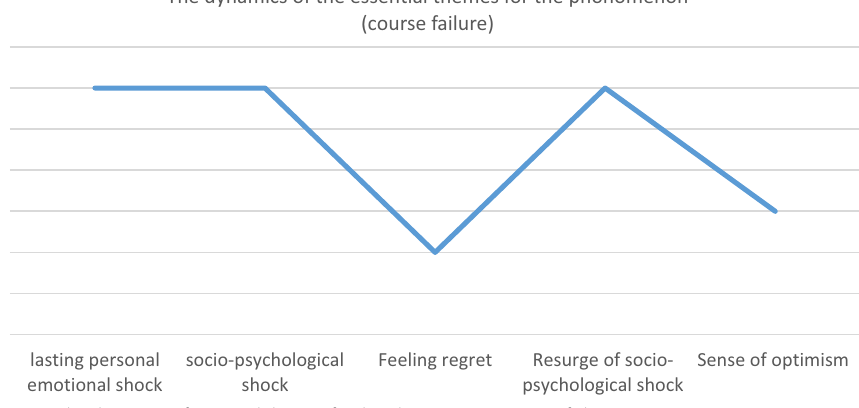
Fig. 1 The dynamics of essential themes for the phenomenon (course